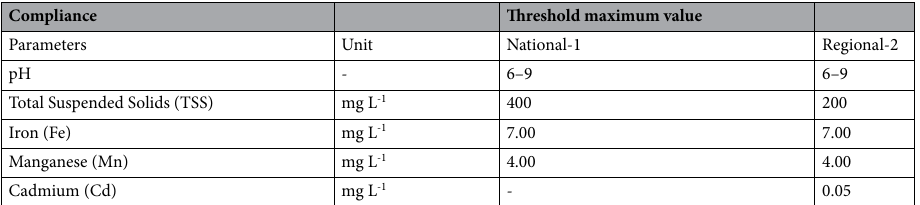
Table 2. Threshold value compliance parameters. National-1 = Decree of Environmental Ministry of Republic Indonesia, Number 113, year 2003. Regional-2 = Regulation of Governor of South Kalimantan, Indonesia, Number 038, year